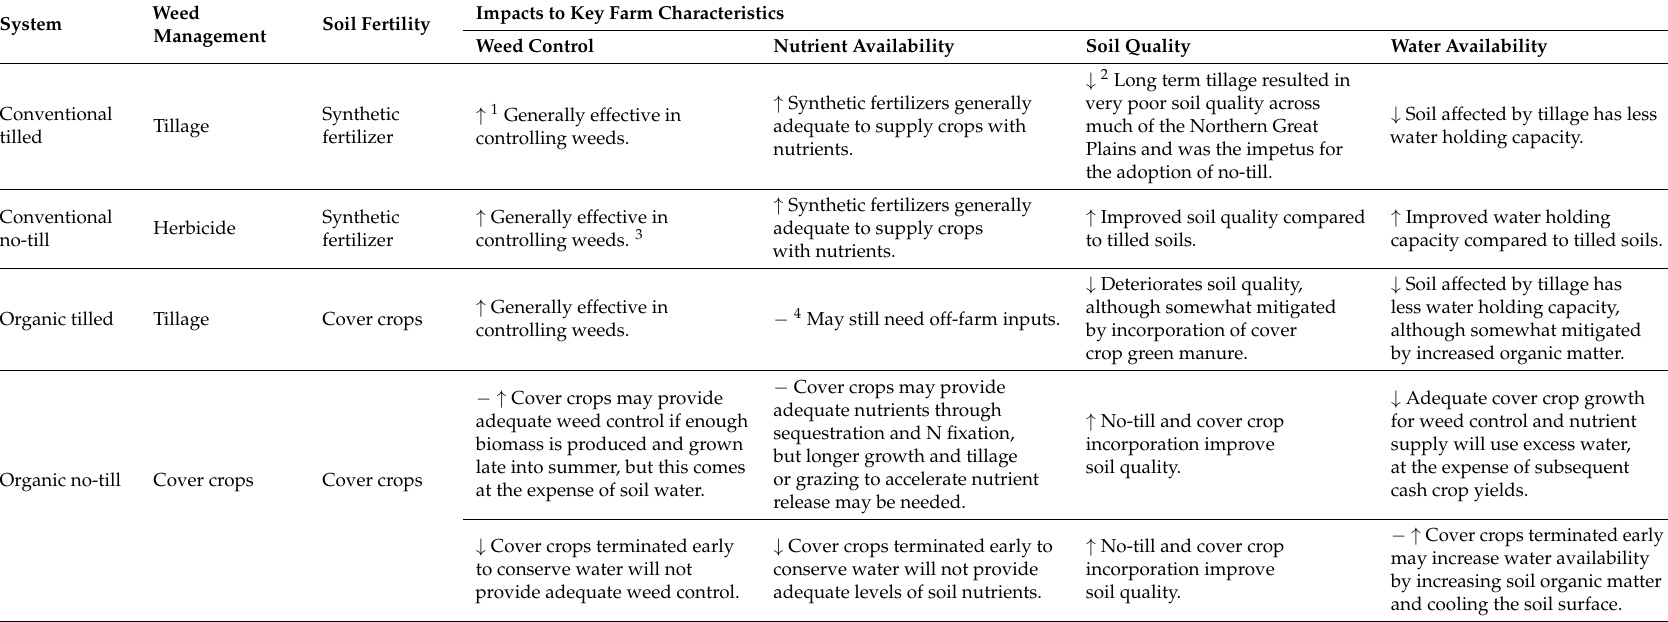
Table 1. Impacts of different farming systems approaches to weed management and soil fertility on weed control, nutrient availability, soil quality, and water availability.